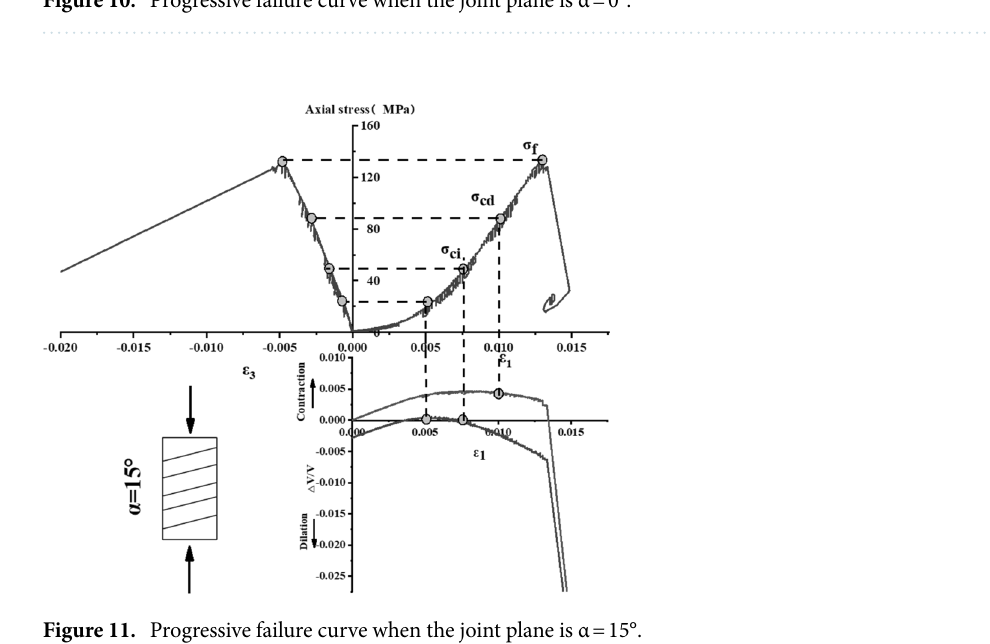
Figure 10. Progressive failure curve when the joint plane is α = 0°.